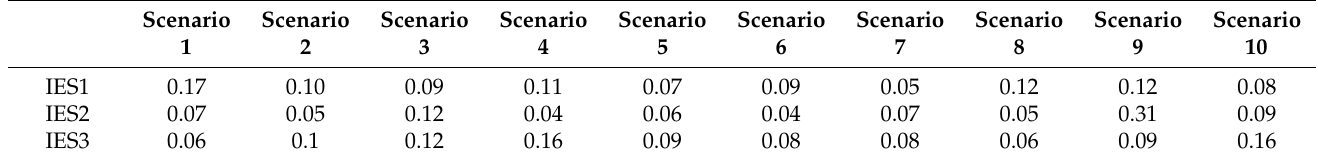
Table A1. Initial scenario probability. denotes the price of hydrogen pipeline transportation, at 10.73 RMB/kg.